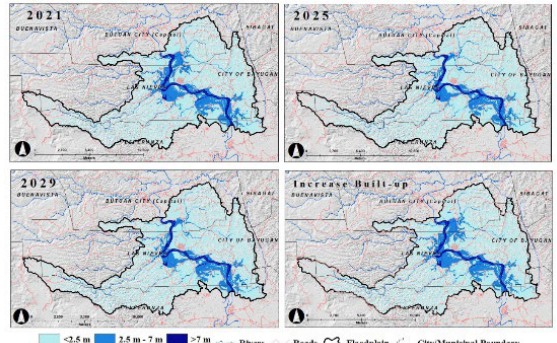
Figure 12 . Flood depth maps with a 100-year rainfall return period